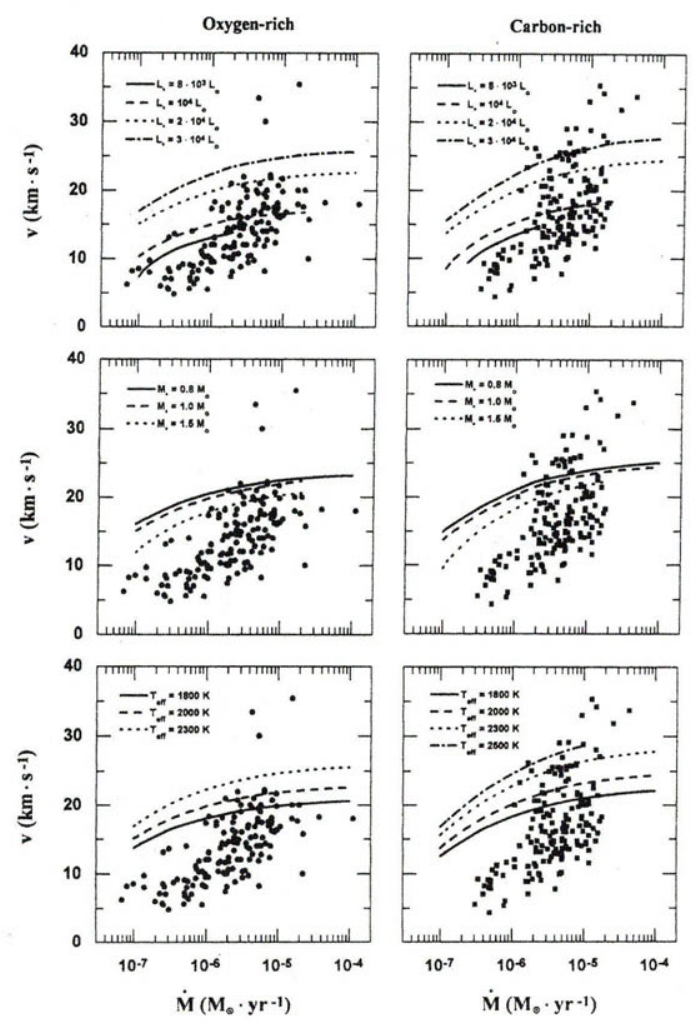
Fig. 3. Terminal outflow velocity versus mass-loss rate for the cal- culated models and individual stars. All model parameters which are not varied are those of the standard model (Table 1), except if stated other- wise. Curves present model calculations for different stellar luminosities (upper raw), masses (middle raw; L* = 2x 10 4 L q ) and effective tempera- tures (bottom raw; L+ = 2 X 10 4 Z Q ). Individual observations are plotted as dots (oxygen-rich stars, left panels) and squares (carbon-rich stars, right